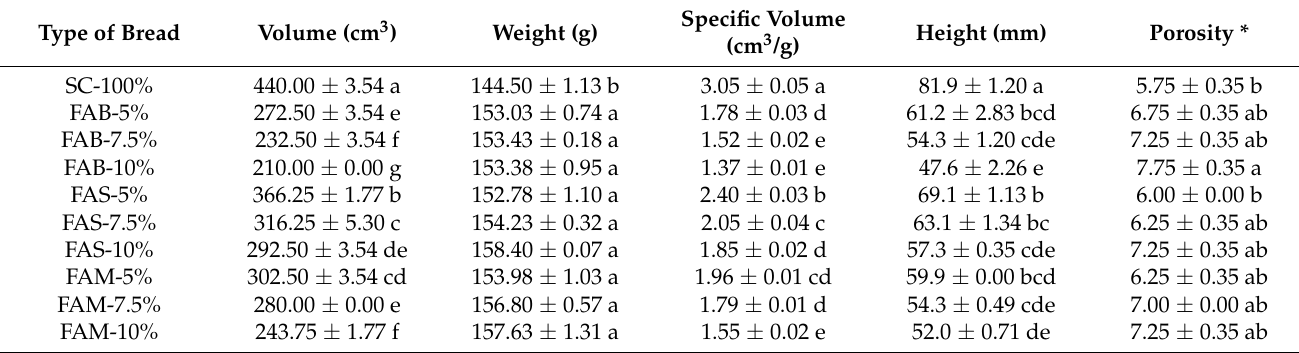
Table 6. Physical characteristics of durum wheat bread at increasing levels of replacement (5, 7.5, 10%) of re-milled semolina (control) with flours prepared from artichoke stems and bracts.